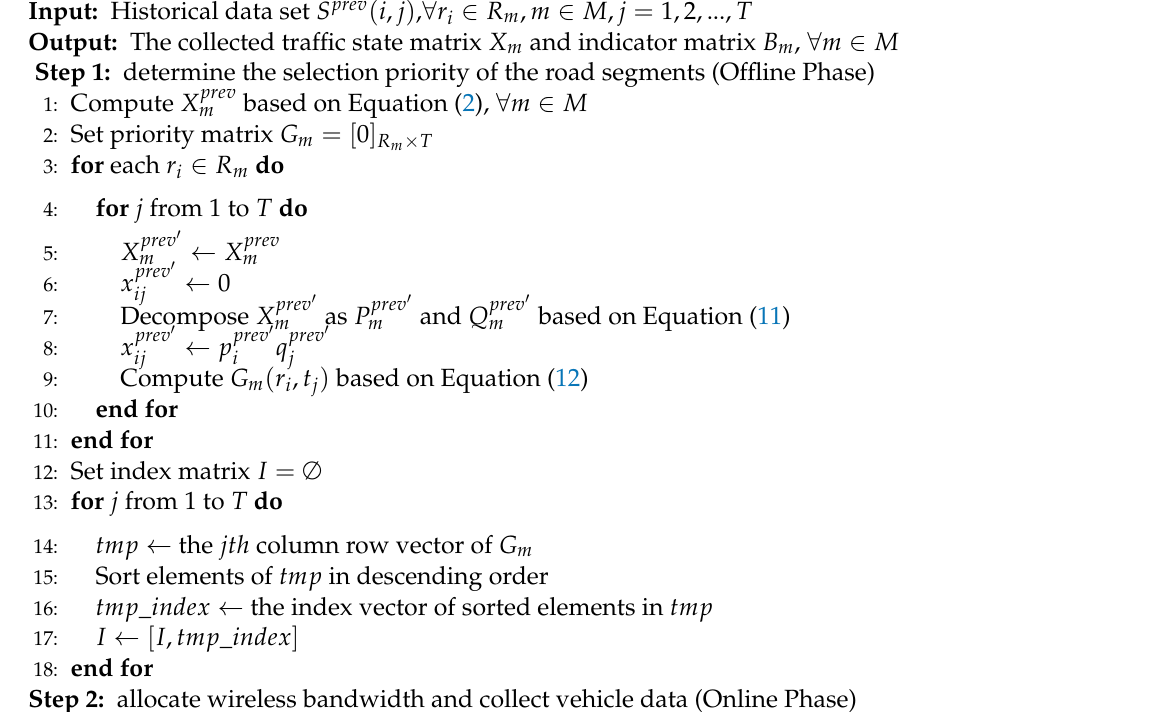
Algorithm 1 The Bandwidth-aware Data Collection (BDC) Algorithm